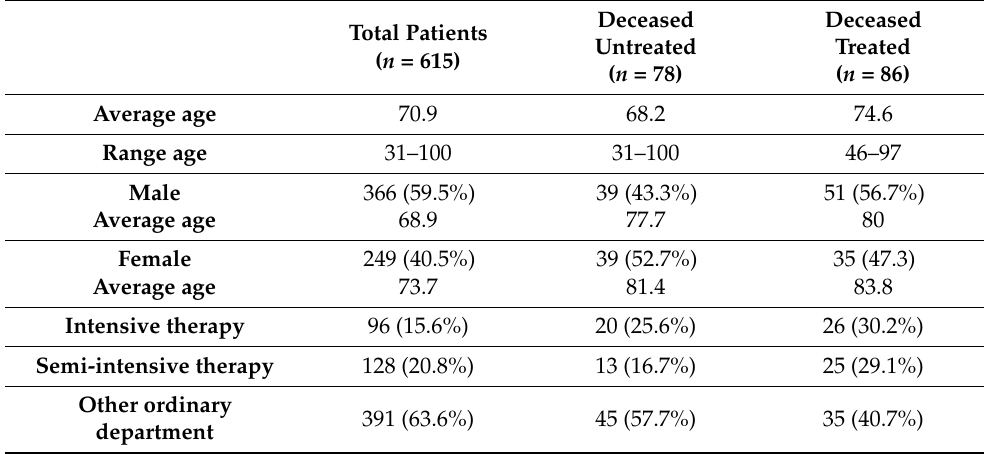
Table 1. Characteristics of the patients under